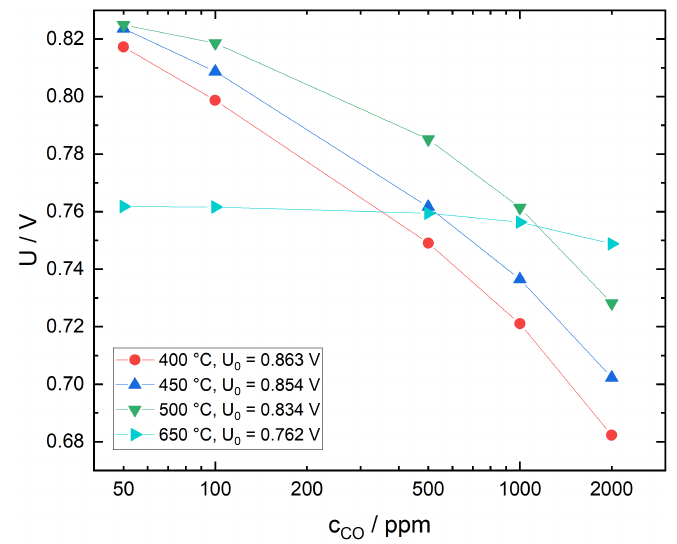
Figure 7. Sensor with ITO sensing electrode, sensor voltage as function of CO concentration for different temperatures in N 2 with 12.5vol% O 2 . Baseline sensor voltages in the absence of CO are given by U 0 .